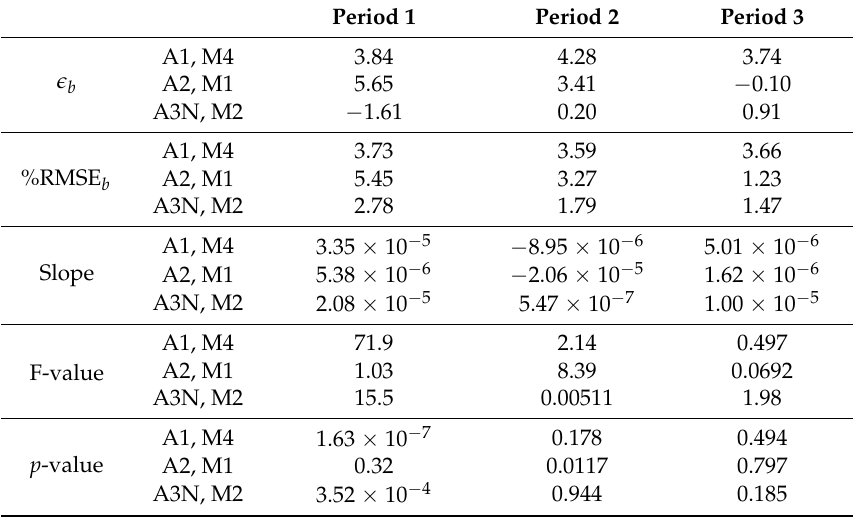
Table 3. Values of (cid:101) b and %RMSE b for periods 1, 2, and 3, the slopes of the regression lines for the relative differences between spatially aggregated ASTER radiances and spectrally adjusted MODIS radiances as a function of time, F-statistics obtained from the F-test of the regression model, and p -values for each